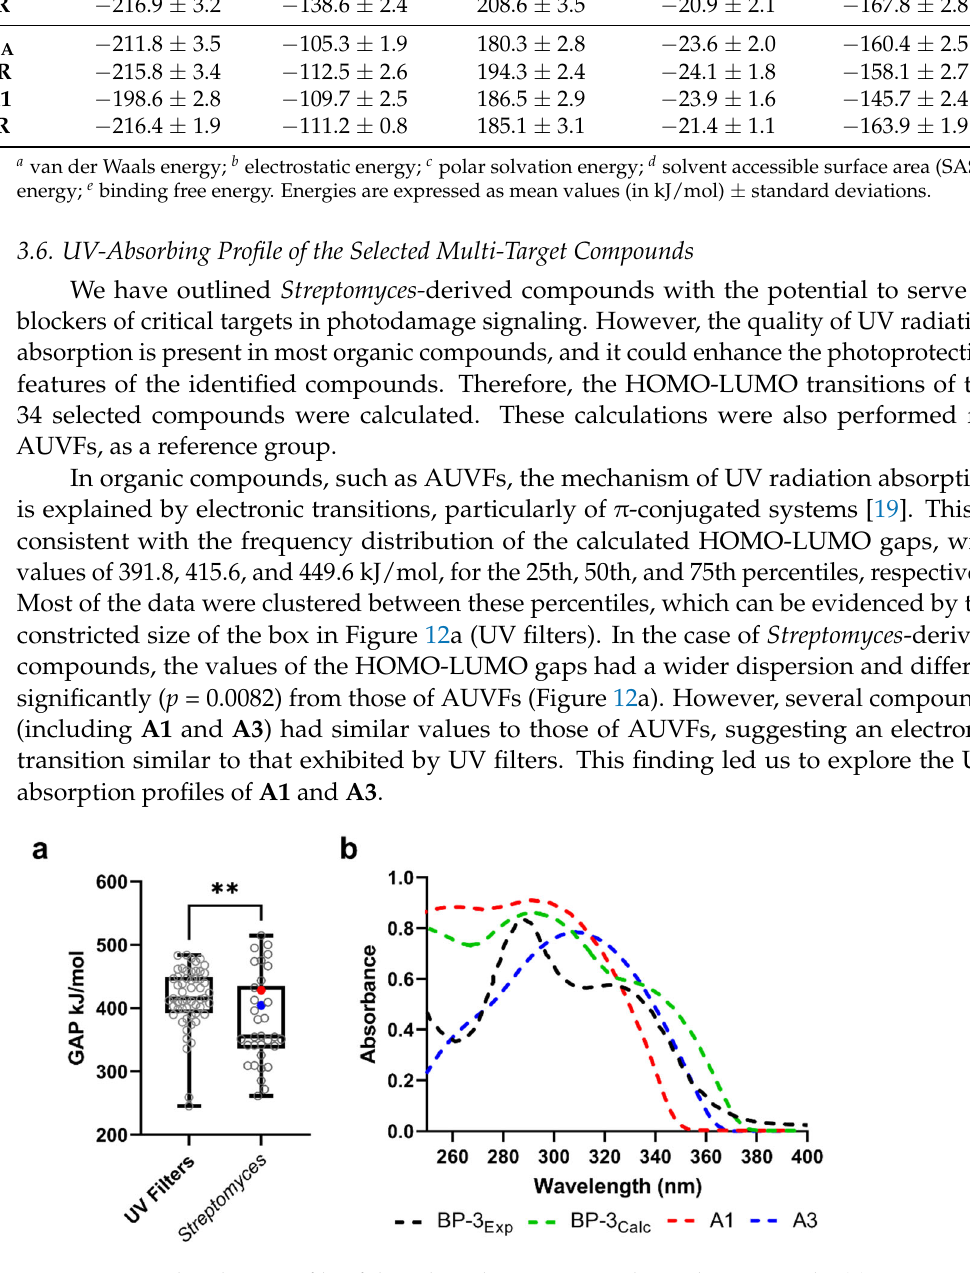
Figure 12. UV-absorbing profile of the selected Streptomyces -derived compounds. ( a ) Comparison between HOMO-LUMO gaps of AUVFs and selected Streptomyces -derived compounds. Red and blue dots are related to the energy gaps of A1 and A3 , respectively. The nonparametric Mann–Whitney U test was used to evaluate the significant difference between the groups; ** p -value = 0.0082. ( b ) Experimental UV spectrum of oxybenzone is compared with the calculated spectra of oxybenzone, A1 and A3 .